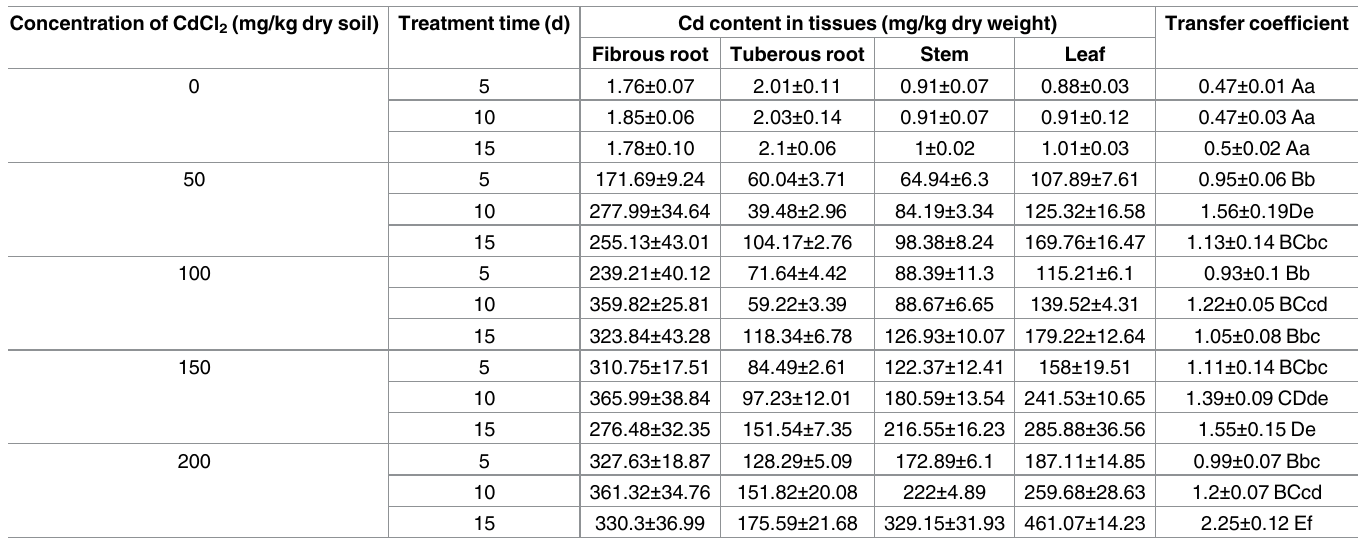
Table 1. Cadmium content and transfer coefficient in P . americana